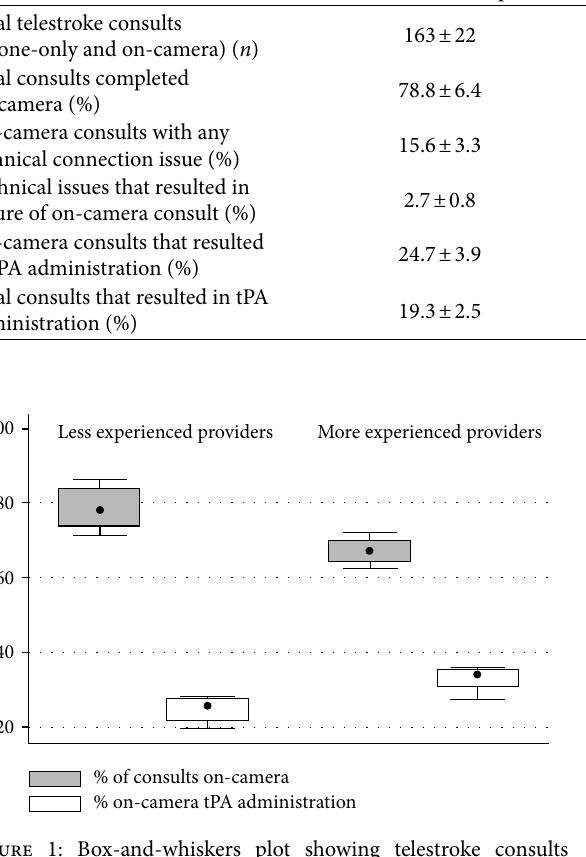
Figure 1: Box-and-whiskers plot showing telestroke consults on-camera and tPA provided on-camera between providers with less and more experience, with box representing interquartile range, dot the median, and whiskers